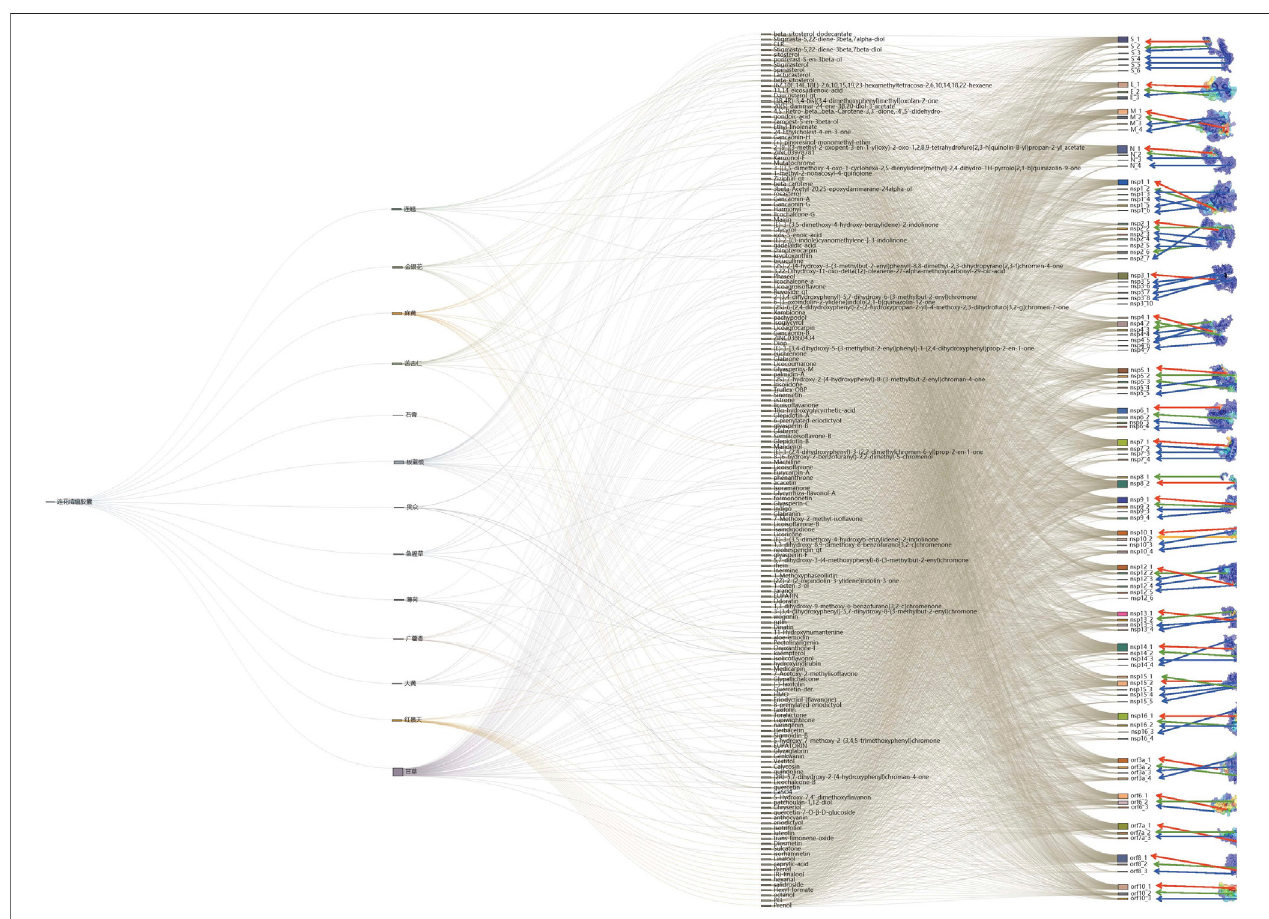
FIGURE 2 | Diagram of docking results of herbal medicine compounds.